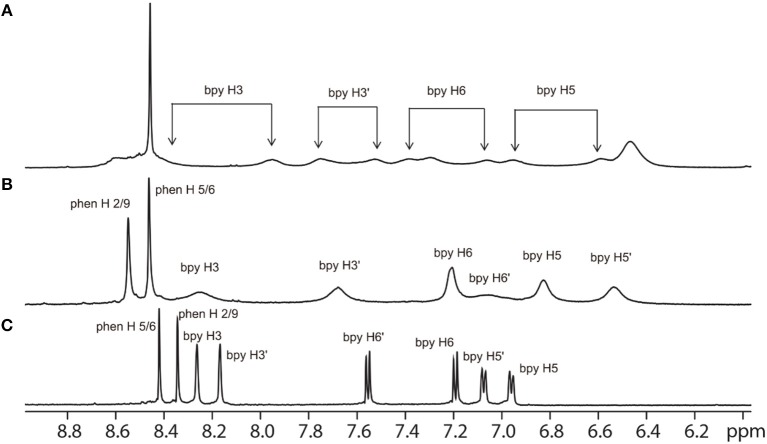
1H NMR spectrum of the aromatic region of the free α-Me4phen-7 (C) and with added Q[10], at Q[10] to α-Me4phen-7 ratios of 0.75 (B) and 1.0 (A).